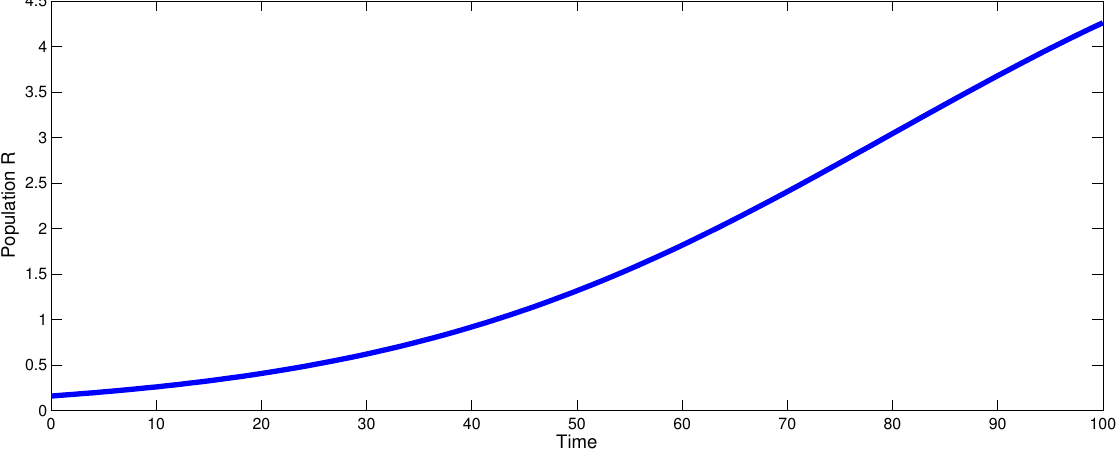
Fig. 10. The control diagram of the recovered population ( R ) based on Tables 1, 2 and G 1 = 0 . 005 , G 2 = 1000 from 30 / 4 / 2020 to 7 / 8 / 2020